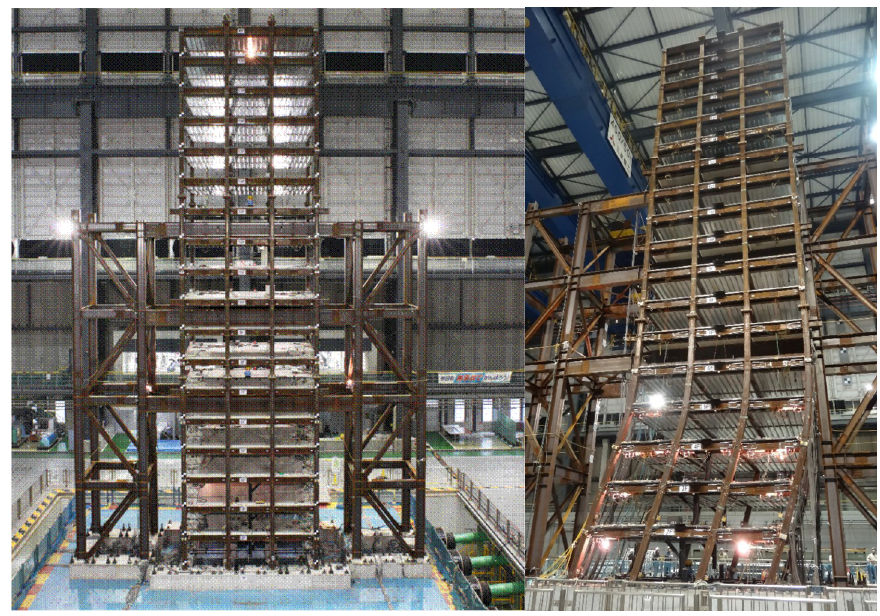
Figure 2. Overview of a 1/3-scale 18-story steel building structure ( left ) and collapsed situation of lower stories ( right ).